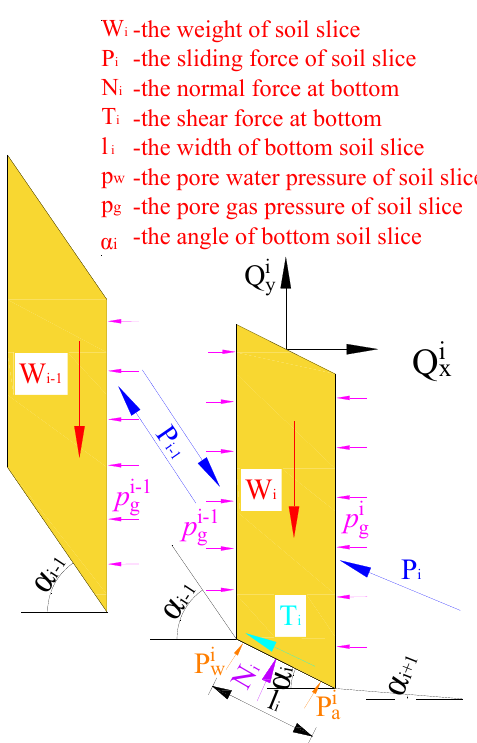
Figure 3. Diagram illustrating the calculation of the residual thrust method considering pore gas pressure.